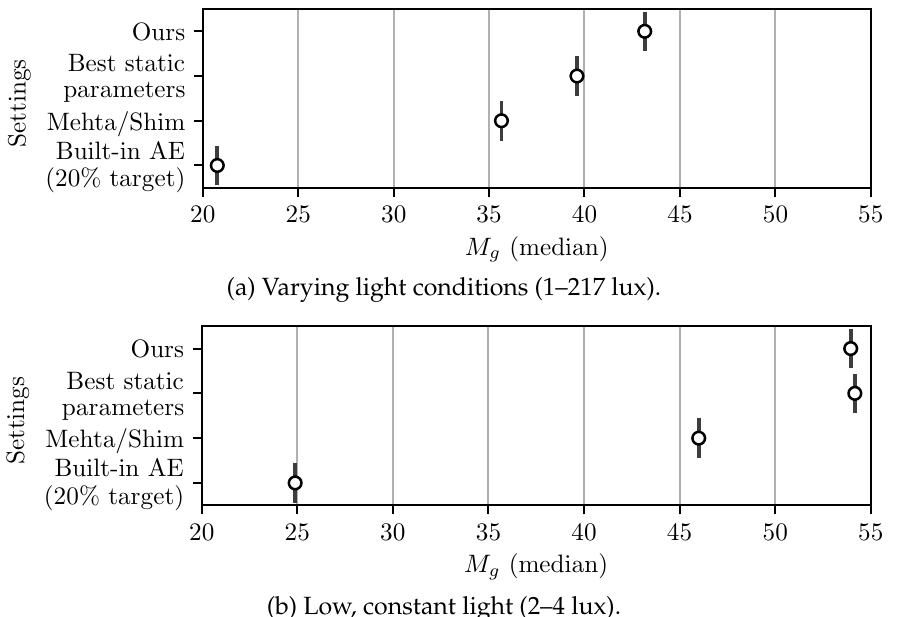
Figure 12. Median gradient information metric M g over the whole trajectory repeated using different AE algorithms: ( a ) Sequences where lighting varies greatly (1–217 lux). ( b ) Sequences with low, but constant lighting (2–4 lux).